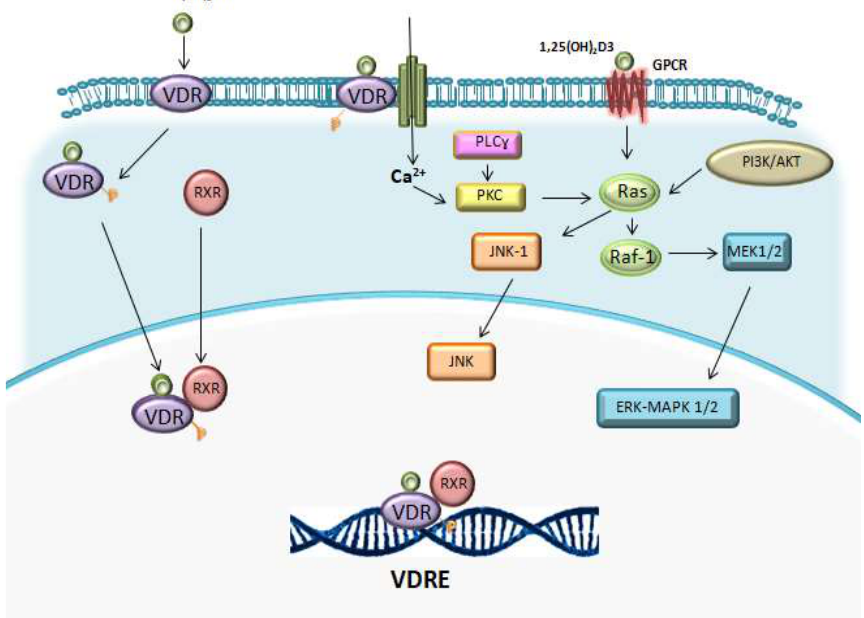
Figure 2. 1,25(OH) 2 D3 acts mediating lipid signalling pathways (protein kinase C pathway), phosphatidylinositol-3-kinase (PI3K)-AKT pathway and mitogen activated kinase (MAPK) pathways.